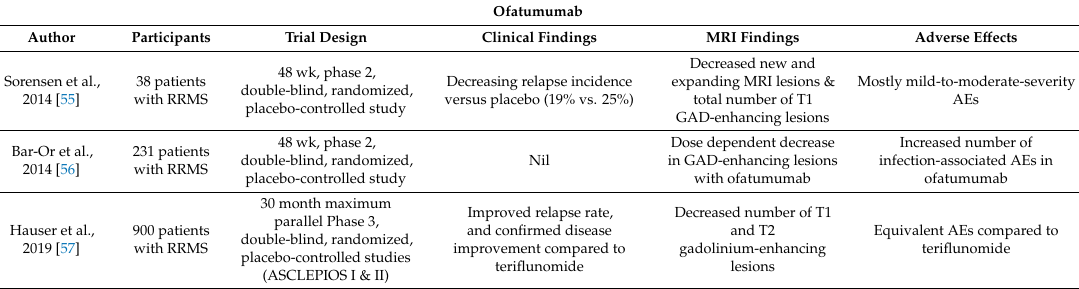
Table 3. A Summary of Clinical Trials Using